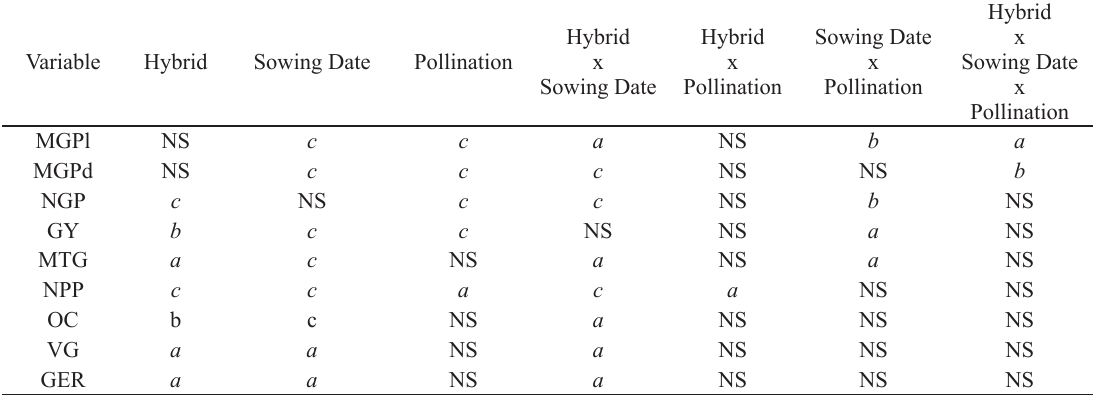
Summary of the significance probability of the initial analysis of variance for each dependent